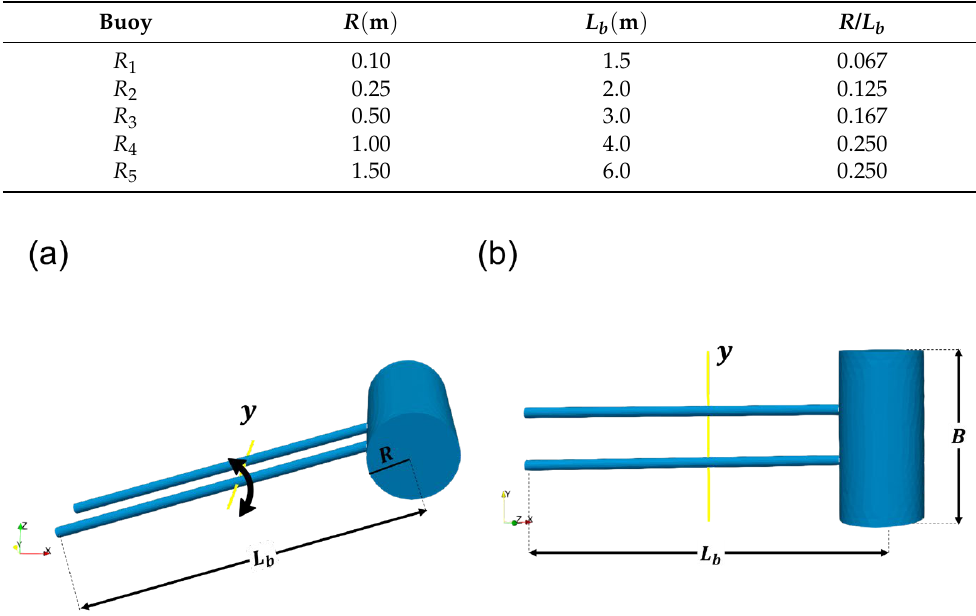
; is the characteristic width (1 m) and 𝑅𝑅 𝐵𝐵